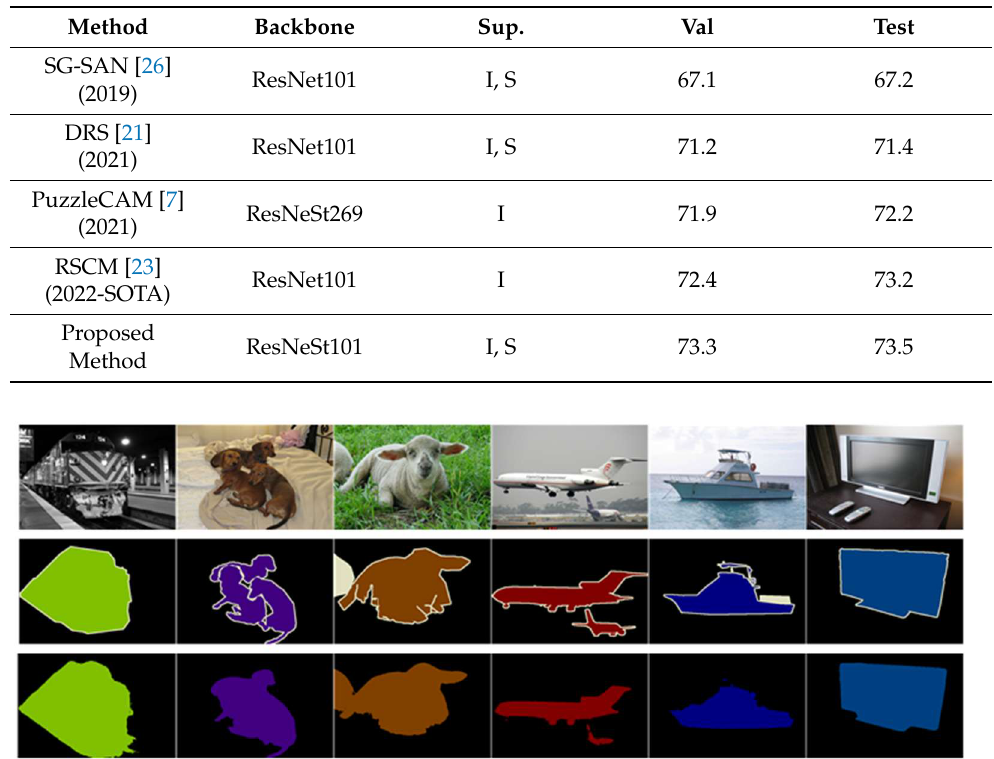
Table 6. Comparison of semantic segmentation results against the state-of-the-art methods with MIOU (%).